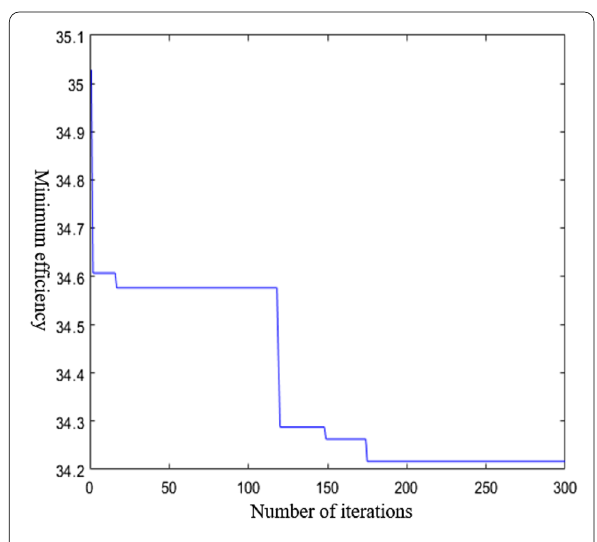
Figure 9 Convergence curve